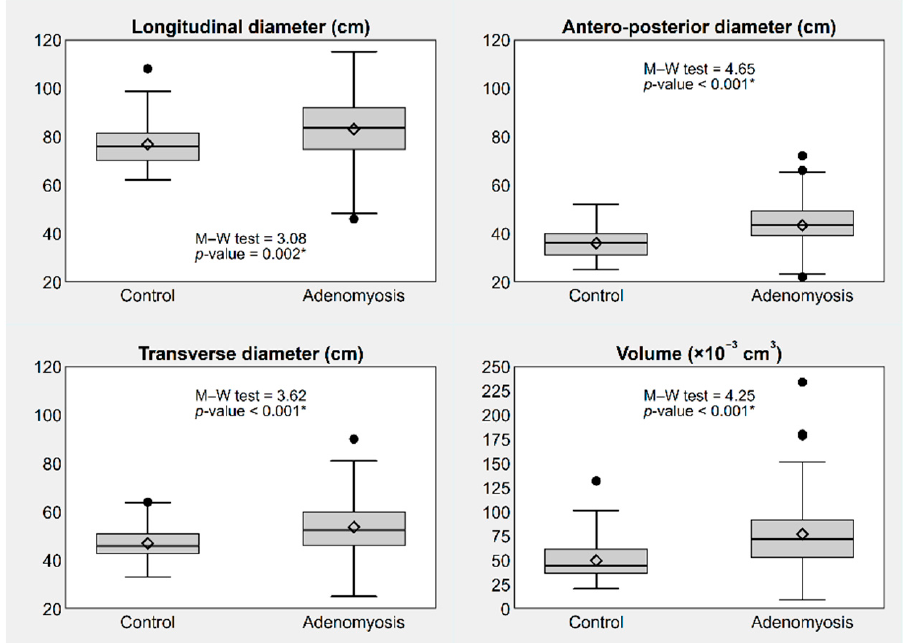
Figure 2. Box plots showing absolute uterine diameters and volume of the uterus, by presence or absence of adenomyosis. * p -value ≤ 0.05. Notes: The box represents the interquartile range (IQR), i.e., the distance between the 1st and the 3rd quartile (Q1, Q3); the bar and diamond inside the box represent the median and the mean, respectively; the whiskers represent the lower and upper adjacent values, i.e., the lowest observation ≥ Q1 − 1.5 × IQR and the largest observation ≤ Q3 + 1.5 × IQR; the circles represent the individual values observed outside the whiskers (outliers). Similarly, simple and complex diameter ratios were statistically different between the two groups, except for TD/(LD+APD) (Figures 3 and